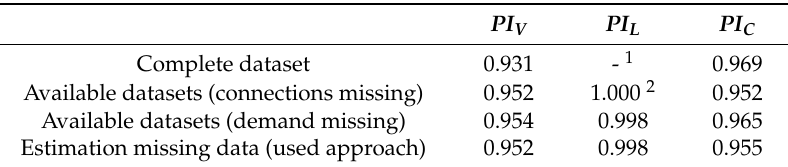
Figure 3. Correlation of infrastructure leakage index ( PI ILI ) with ( a ) total annual water demand, ( b ) volume related PI ( PI V ), ( c ) PI L , and ( d ) PI C . Table 2. Correlations between di ff erent PI s with PI ILI